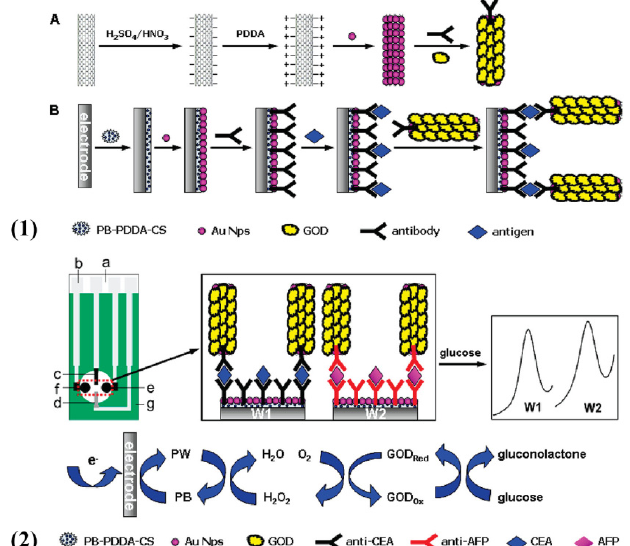
Figure 5. ( 1 ) Schematic representation of the preparation of immunosensors and sandwich-type